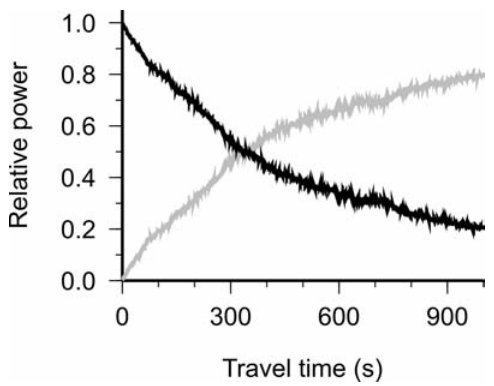
Figure 9. Transmitted (black) and reflected (gray) power averaged over 100 statistical realizations, as in Figure 8.